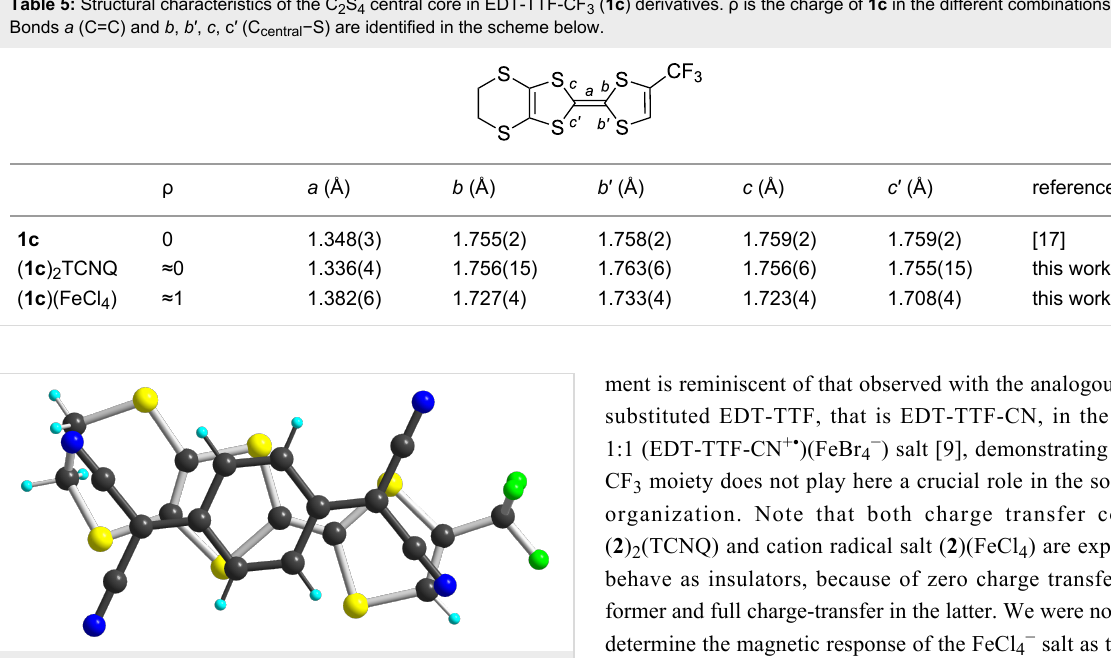
Figure 8: Detail of the overlap between donor and acceptor molecules in ( 1c ) 2 (TCNQ).